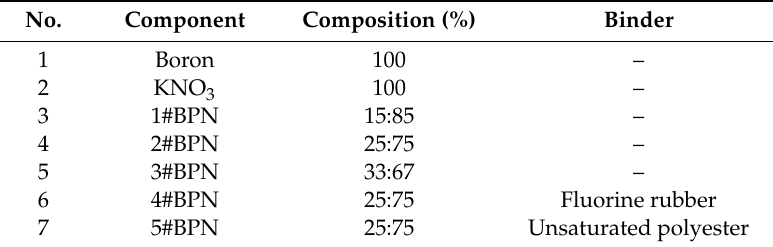
Table 1. Samples of pure components and mixtures.